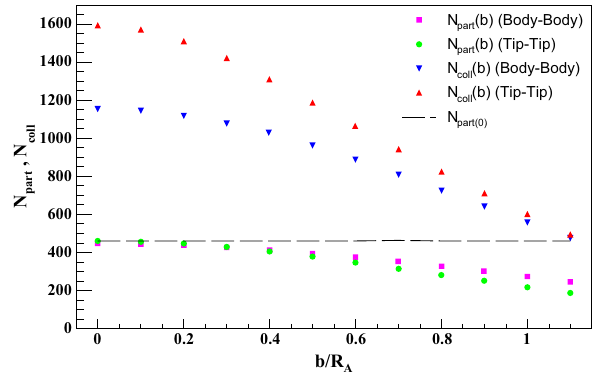
Fig. 5 Variation of N part and N coll with impact parameter for tip–tip and body–body configuration of U + U